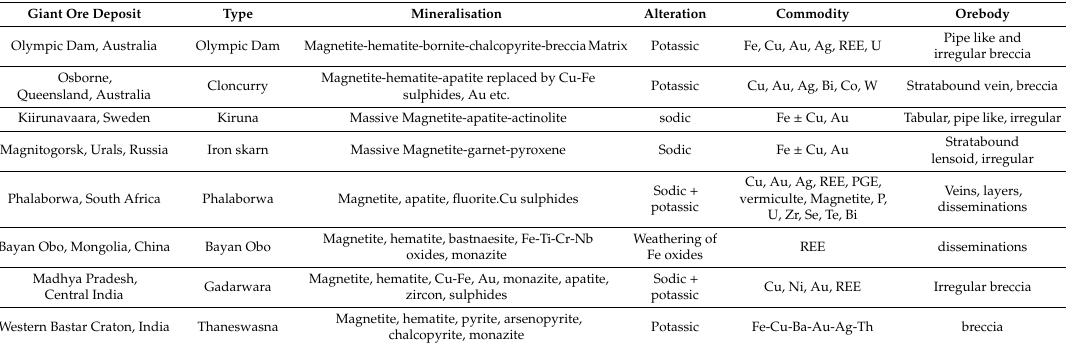
Figure 11. Lithology of DDH-1 drill core with vs assay data.